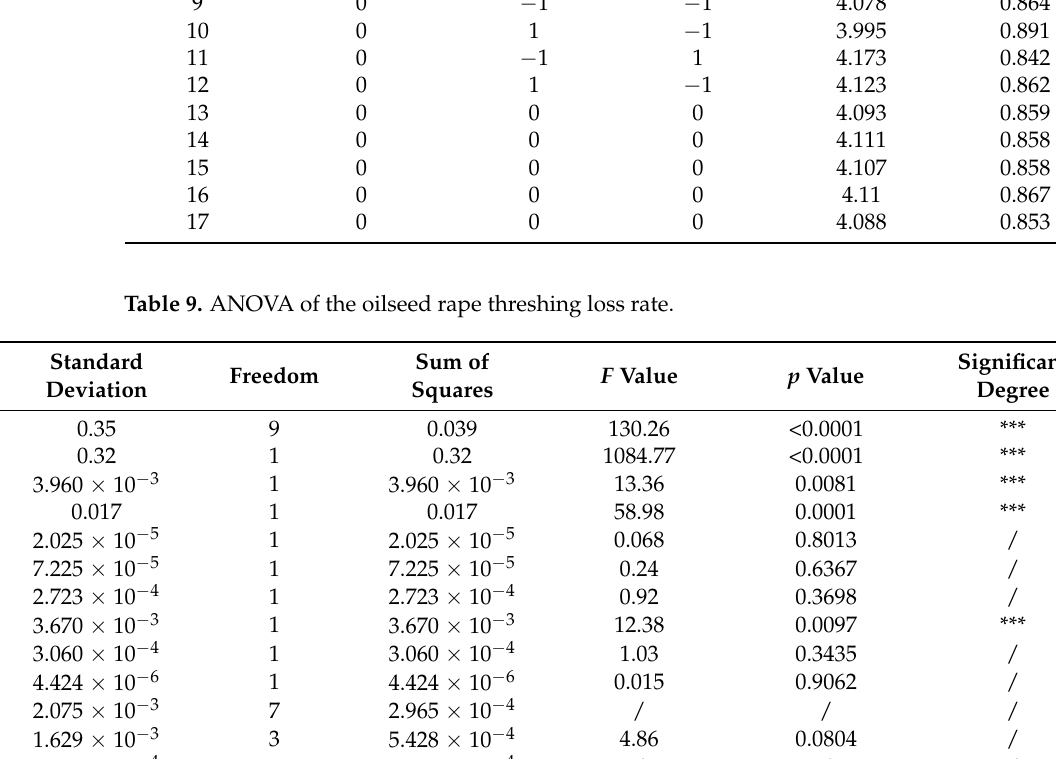
Table 11. The method of least significant difference (LSD) was used for the back